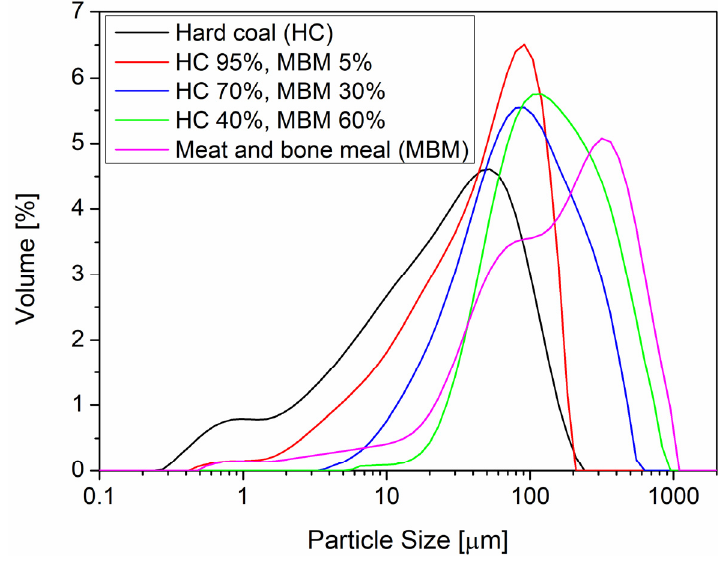
Figure 5. Particle size distribution for MBM with hard coal mixtures.